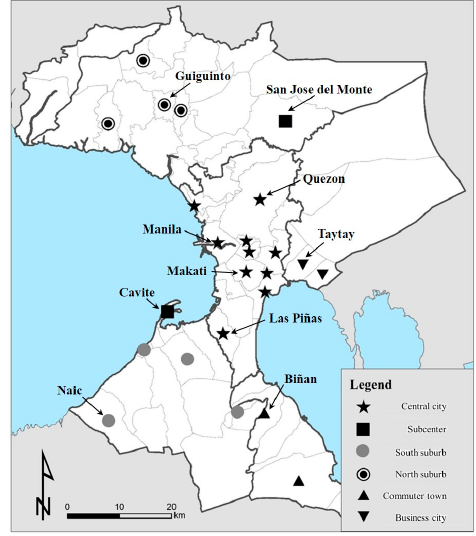
Figure 5. Location of urban nucleuses with different types. Table 3. 12 kinds of activity occurrence rate’s average values of each group. Data source: CSIS, author’s calculations.